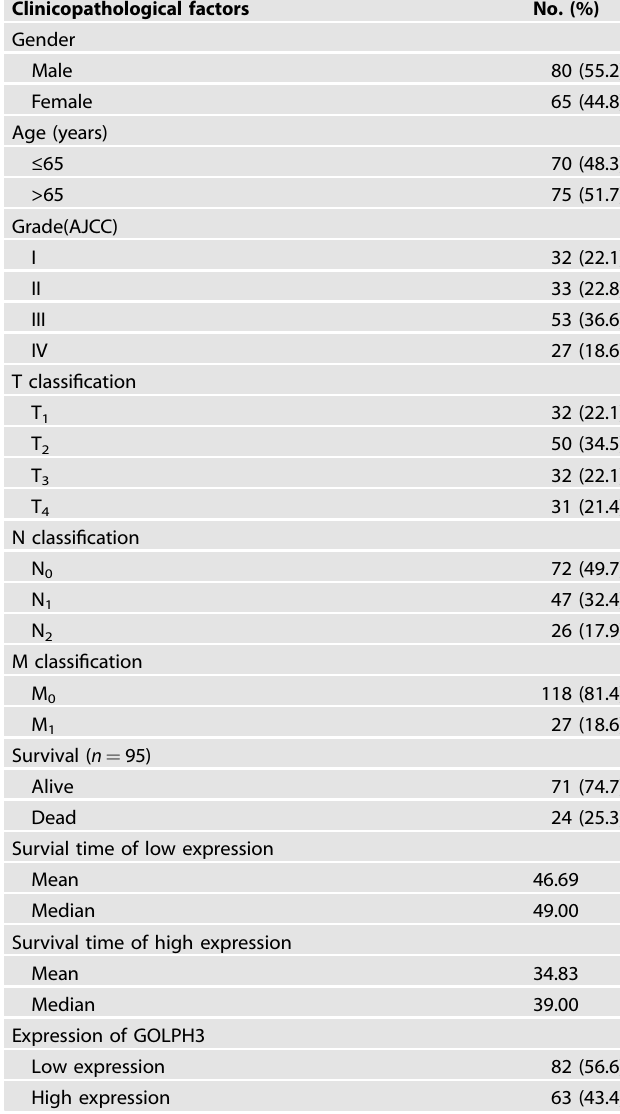
Table 1. Clinicopathologic characteristics of patient samples and expression Of GOLPH3 in colorectal cancer.